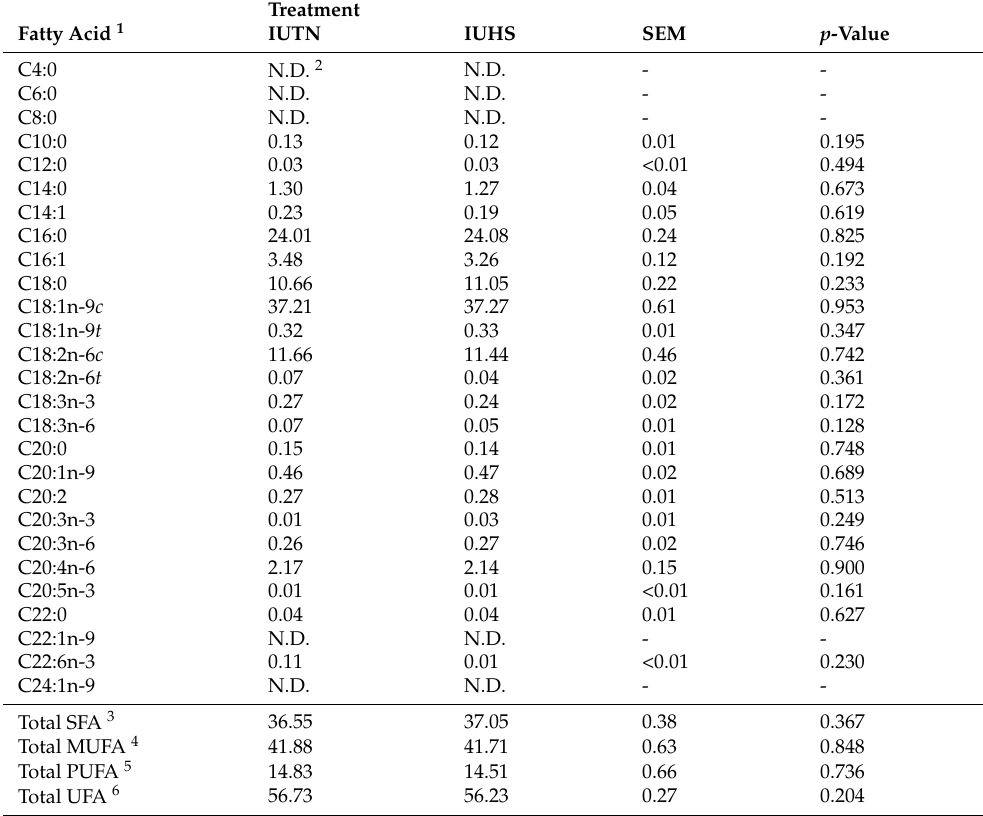
Table 7. Main effect of IUHS treatment on fatty acid profile of pork loin muscle ( n =